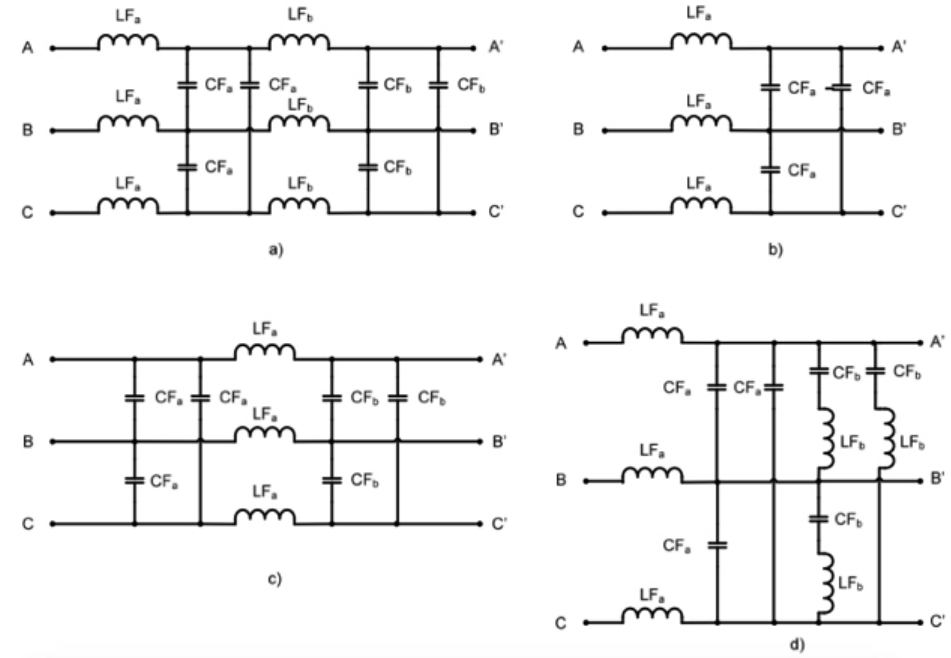
Figure 2. Basic settings of LC input filters used in MC design: ( a ) multi-state, ( b ) single-state, ( c ) filter in connection, and ( d ) filter with one bypass of a